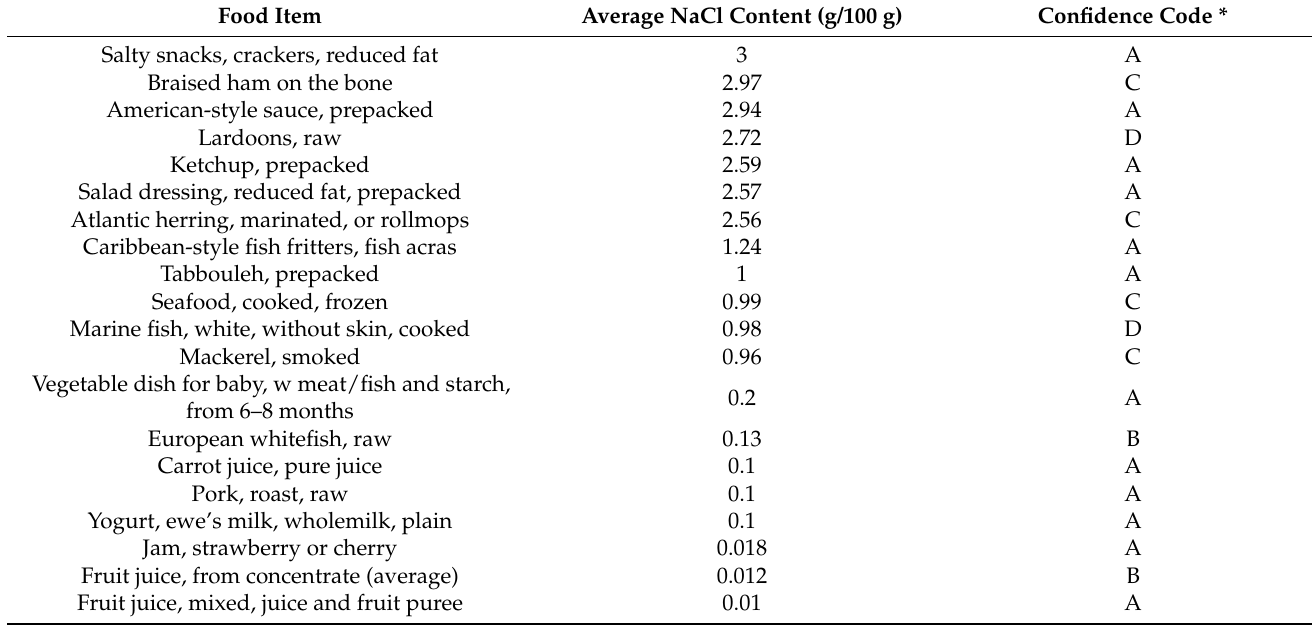
Table 2. NaCl concentration in some foodstuffs found in the French food composition table.